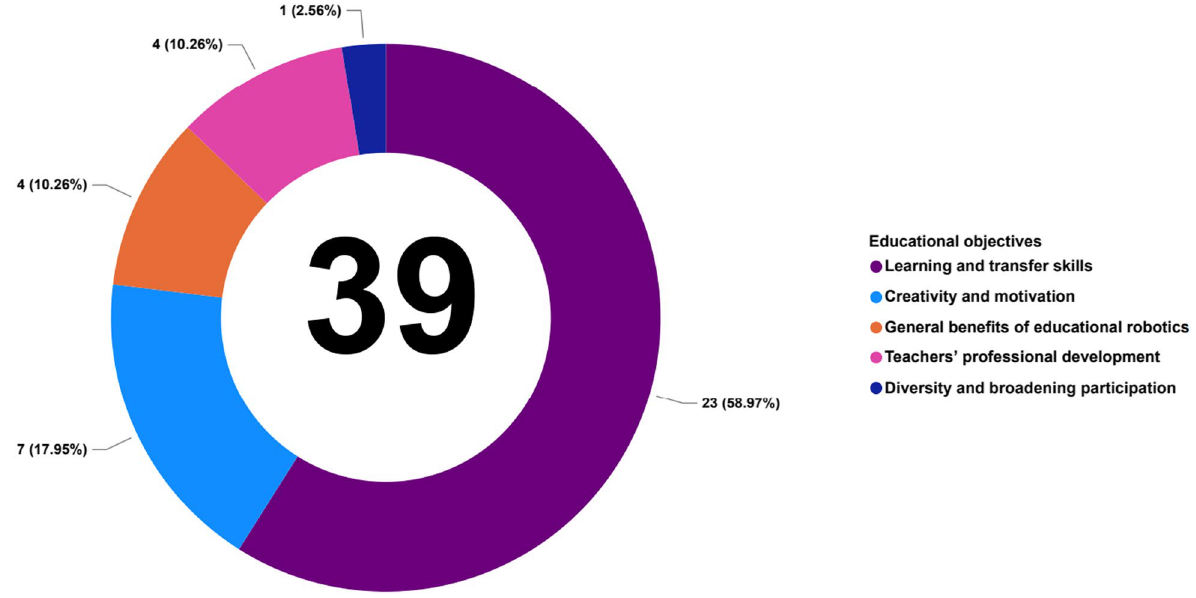
Fig. 13 Educational objectives of R‑STEM